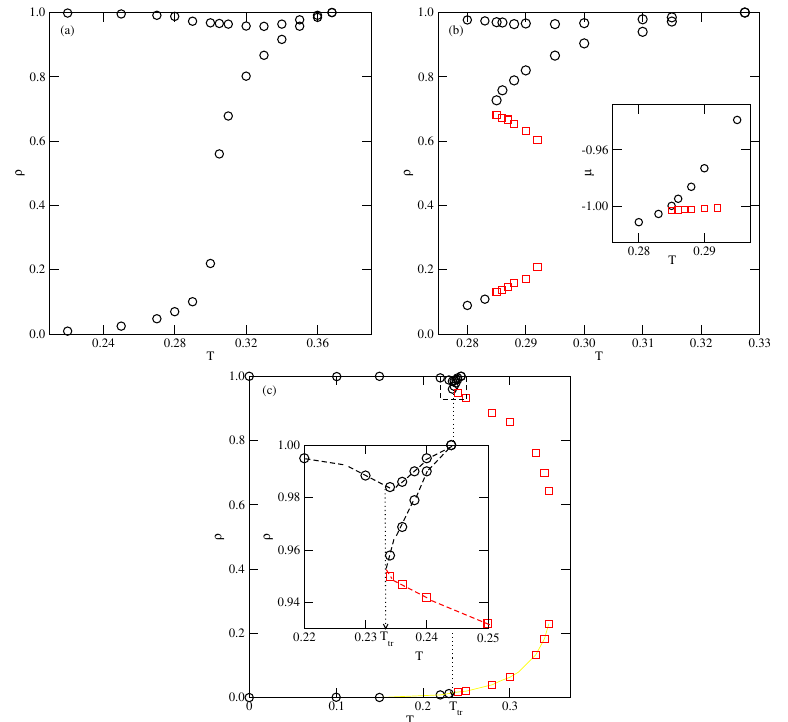
Figure 3. The T − ρ projections of bulk phase diagrams for the systems with u BB = 0 and u AB = − 0.05 ( a ), − 0.1 ( b ) and − 0.2 ( c ). The circles represent the phase boundaries between the disordered and ordered structures, while the squares mark the gas–liquid phase boundaries. The in- set to Figure 4b gives the T − µ projection of the phase diagram for the system with u BB = 0 and u AB = − 0.1. The inset to Figure 4c shows the region of liquid–solid transition in the enlarged scale. Since the stability of the SAF structure is weakened by the AB attraction, both T o ( u AB ) and T tr ( u AB ) decrease when u AB is lowered. Of course, T tr ( u AB ) , which has to be lower than T o ( u AB ) , gradually approaches T o ( u AB ) when u AB decreases towards − 0.5. When u AB < − 0.5, the structure of the orientationally ordered dense phase changes to AF and its stability gradually increases when u AB decreases from − 0.5 to − 1.0. The cal- culations have shown the presence of gas–liquid condensation for any u AB ∈ ( − 0.5 − 1.0 ] . systems with u AB < − 0.5. This was caused by the fact that the liquid–AF transition occurs when the densities are very close to